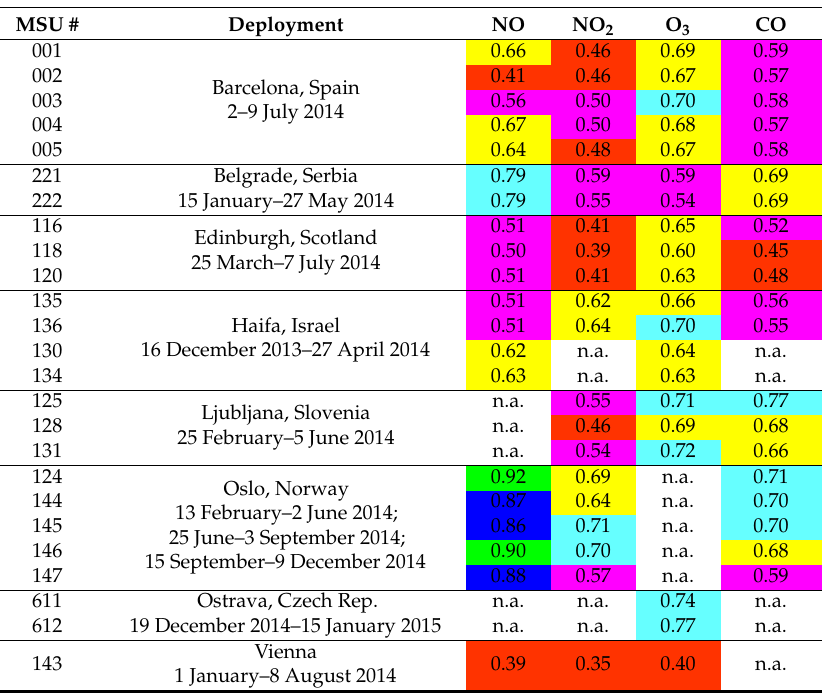
Table 6. Sample Sensor Evaluation Toolkit (SET) analysis. IPI (Integrated Performance Index) of the MSU sensors for ambient nitrogen oxide (NO), nitrogen dioxide (NO 2 ), ozone (O 3 ), and carbon monoxide (CO). Color code: red (<0.50), magenta (0.50–0.59), yellow (0.60–0.69), light blue (0.70–0.79),